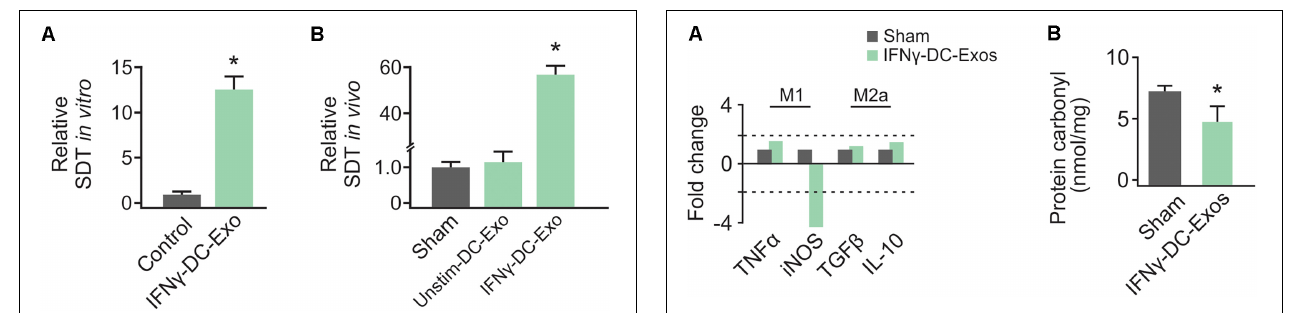
in SD threshold compared to untreated control slices. Specific